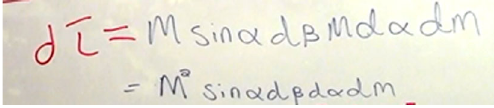
FIG. 2. Final differential volume constructed by Carol and Dan including incorrect trigonometric function.